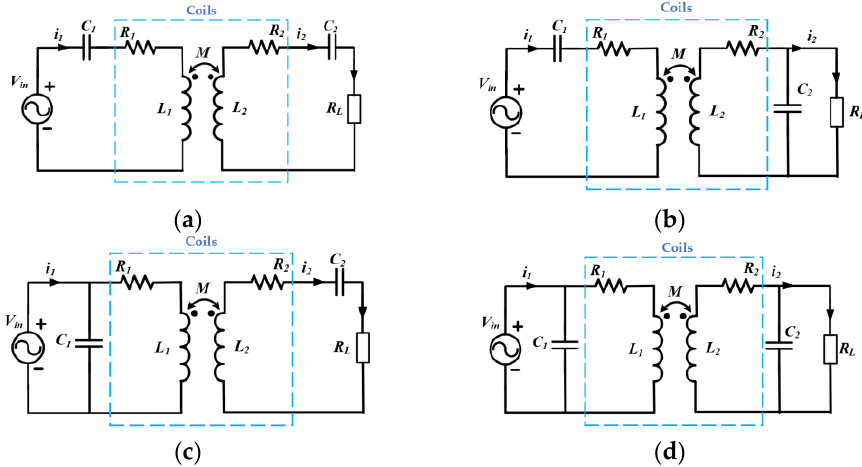
Figure 8. Single-element resonant compensations. ( a ) Series – series. ( b ) Series – parallel. ( c ) Parallel – series. ( d ) Parallel-parallel.